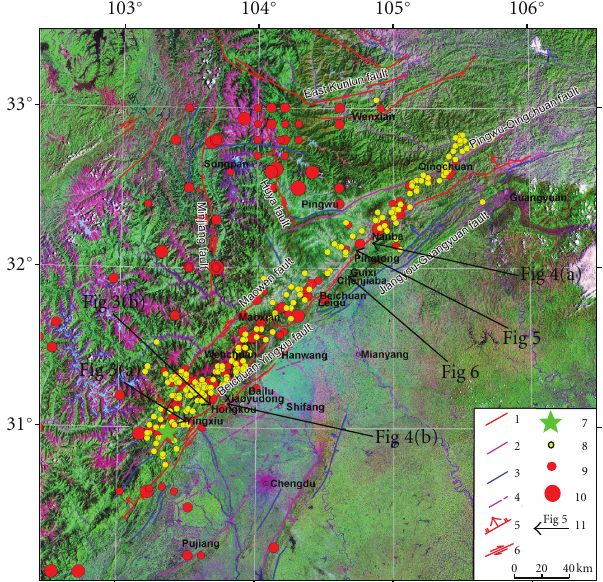
Figure 1: Seismotectonics and distribution of historical earth- quakes of the Wenchuan area. (1) Holocene active fault. (2) Late Pleistocene active fault. (3) Early and middle Pleistocene active fault. (4) Buried active fault. (5) Normal fault. (6) Strike-slip fault. (7) Ms 8.0 earthquake surface ruptures. (8) Epicenter of the Ms 8.0 earthquake. (9) Historical earthquakes ranging from M s 4.7 to 5.0. (10) Historical earthquakes ranging from M s 4.7 to 5.0. (11) Figure location.